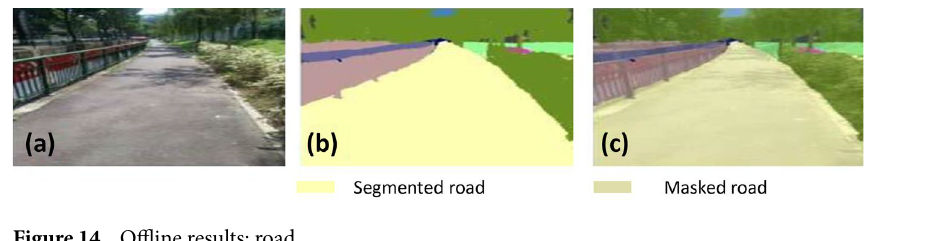
Figure 14. Offline results: